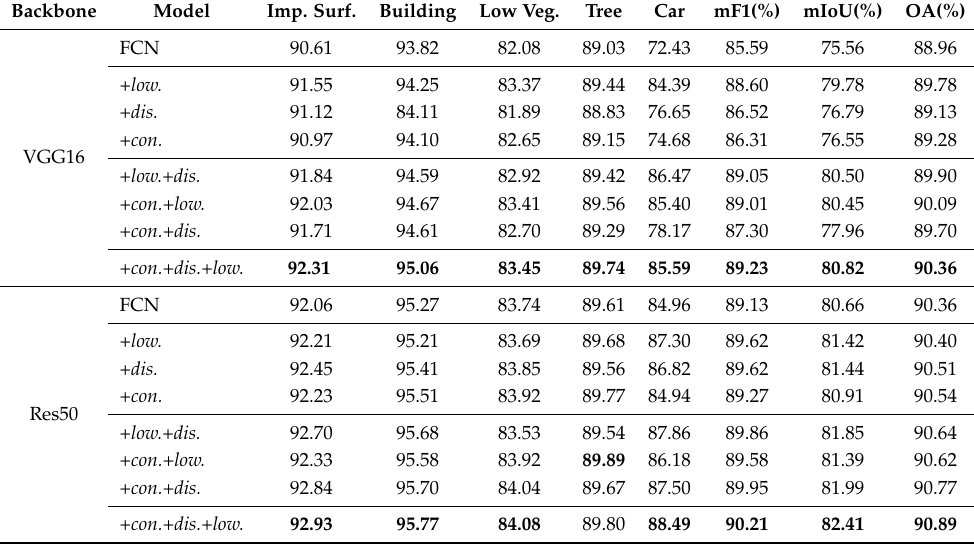
Table 3. The result of ablation study of multi-feature learning in Vaihingen dataset.